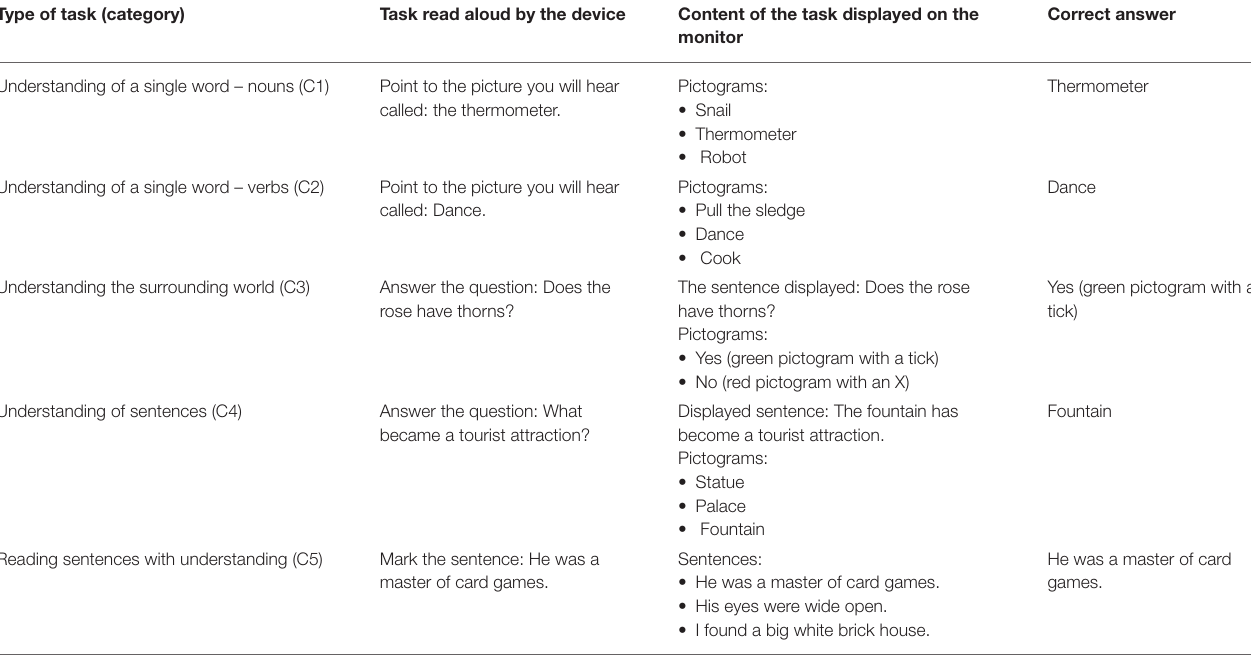
TABLE 2 | Categories (C) with examples of tasks involving language functions. Type of task